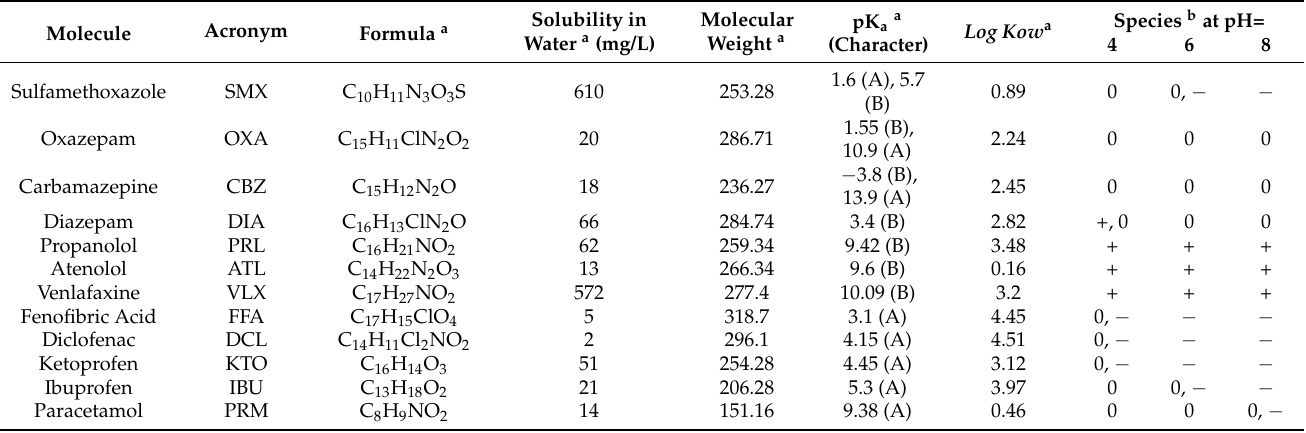
Table 2. Physicochemical properties of the studied